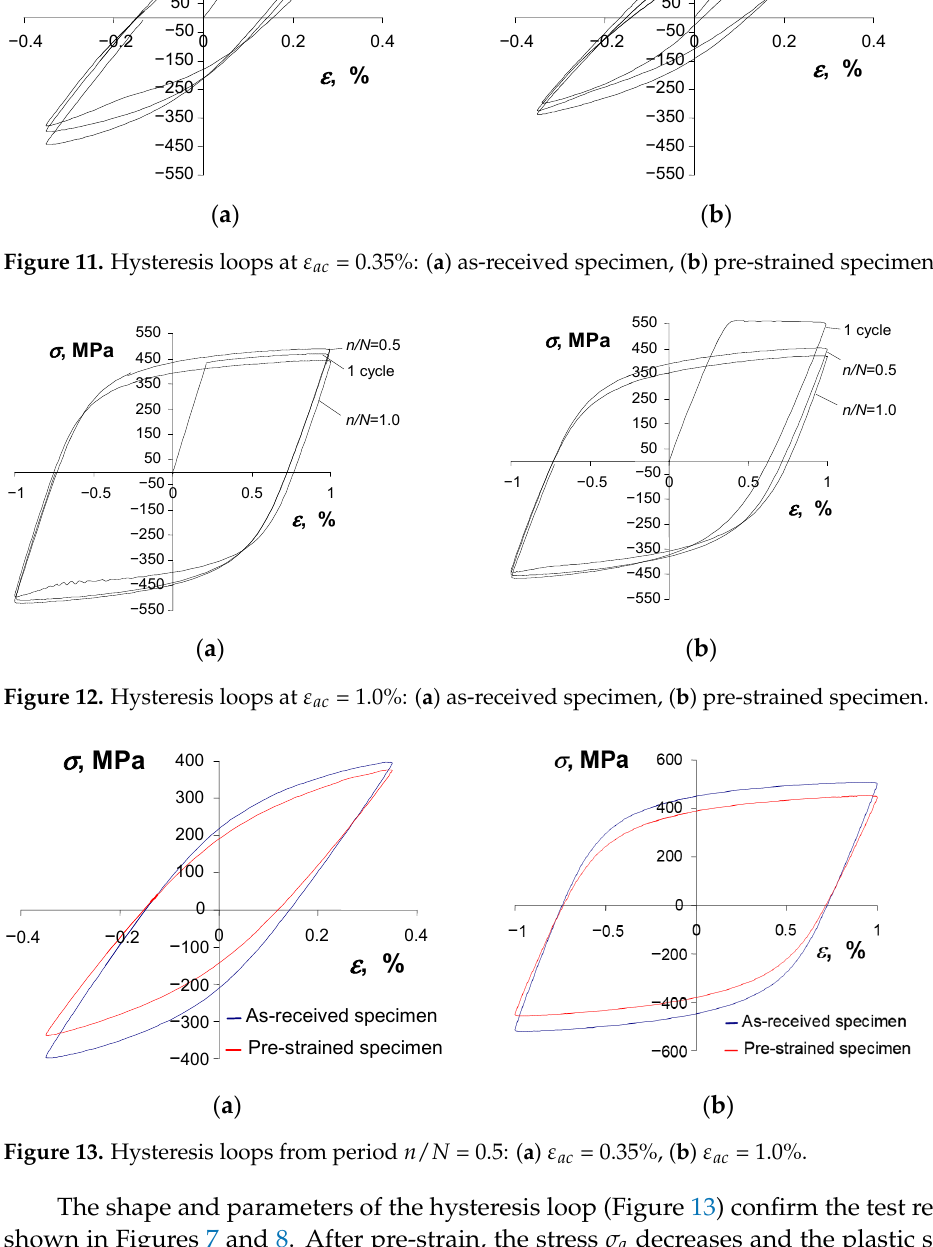
Figure 13. Hysteresis loops from period 𝑛/𝑁 = 0.5: ( a ) 𝜀 𝑎𝑐 = 0.35%, ( b ) 𝜀 𝑎𝑐 = 1.0%.